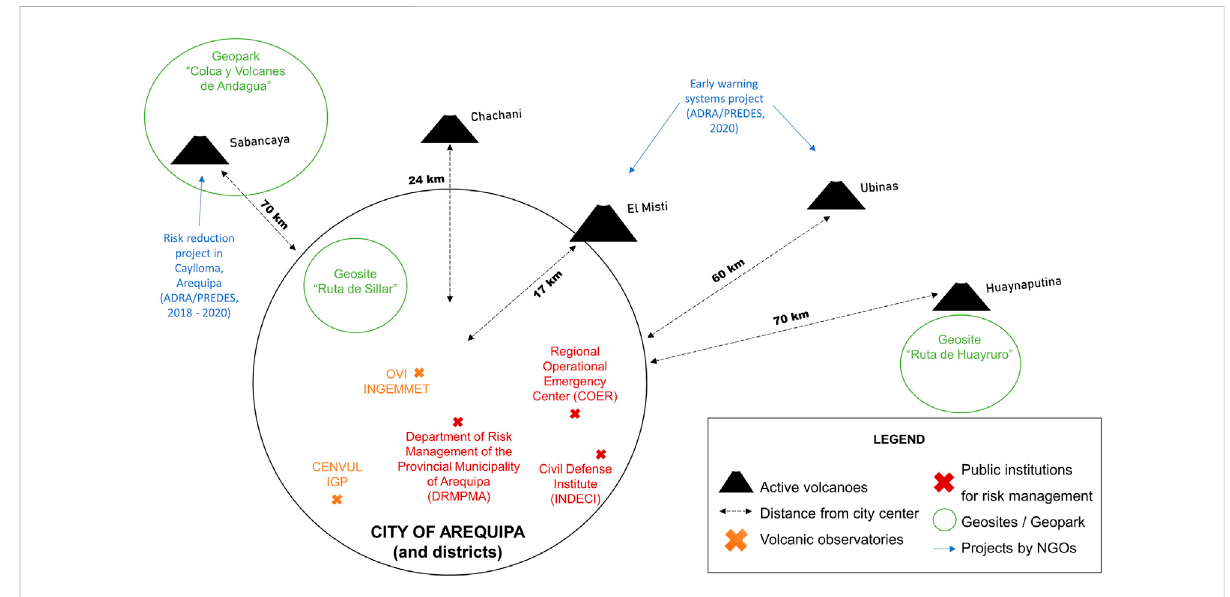
FIGURE 2 Volcanic context and risk management stakeholders in and around